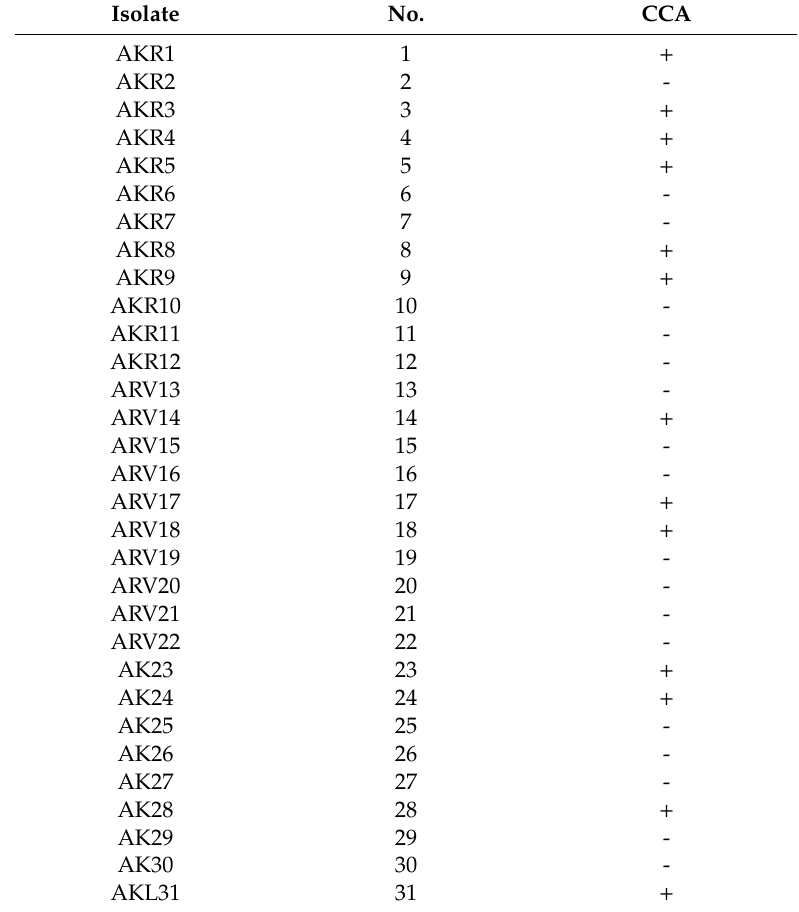
Figure 7. The distribution of the aflatoxigenic and the non-aflatoxigenic A. flavus isolates in four sweet corn-growing farms in Malaysia. Black bars = number of A. flavus isolates and their respective percentage figure. Table 1. Identification of the aflatoxin production through UV fluorescence screening.